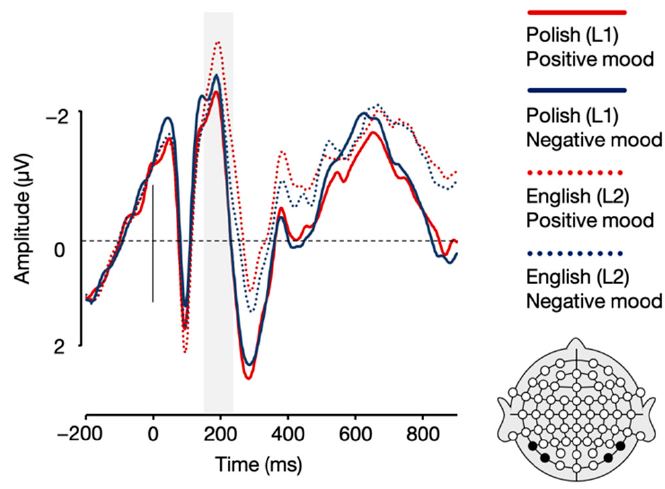
Figure 5. Grand averages for Polish (L1) and English (L2) sentences in the positive and negative mood conditions over parietal (P7, P8) and parieto-occipital (PO7, PO8) electrodes.